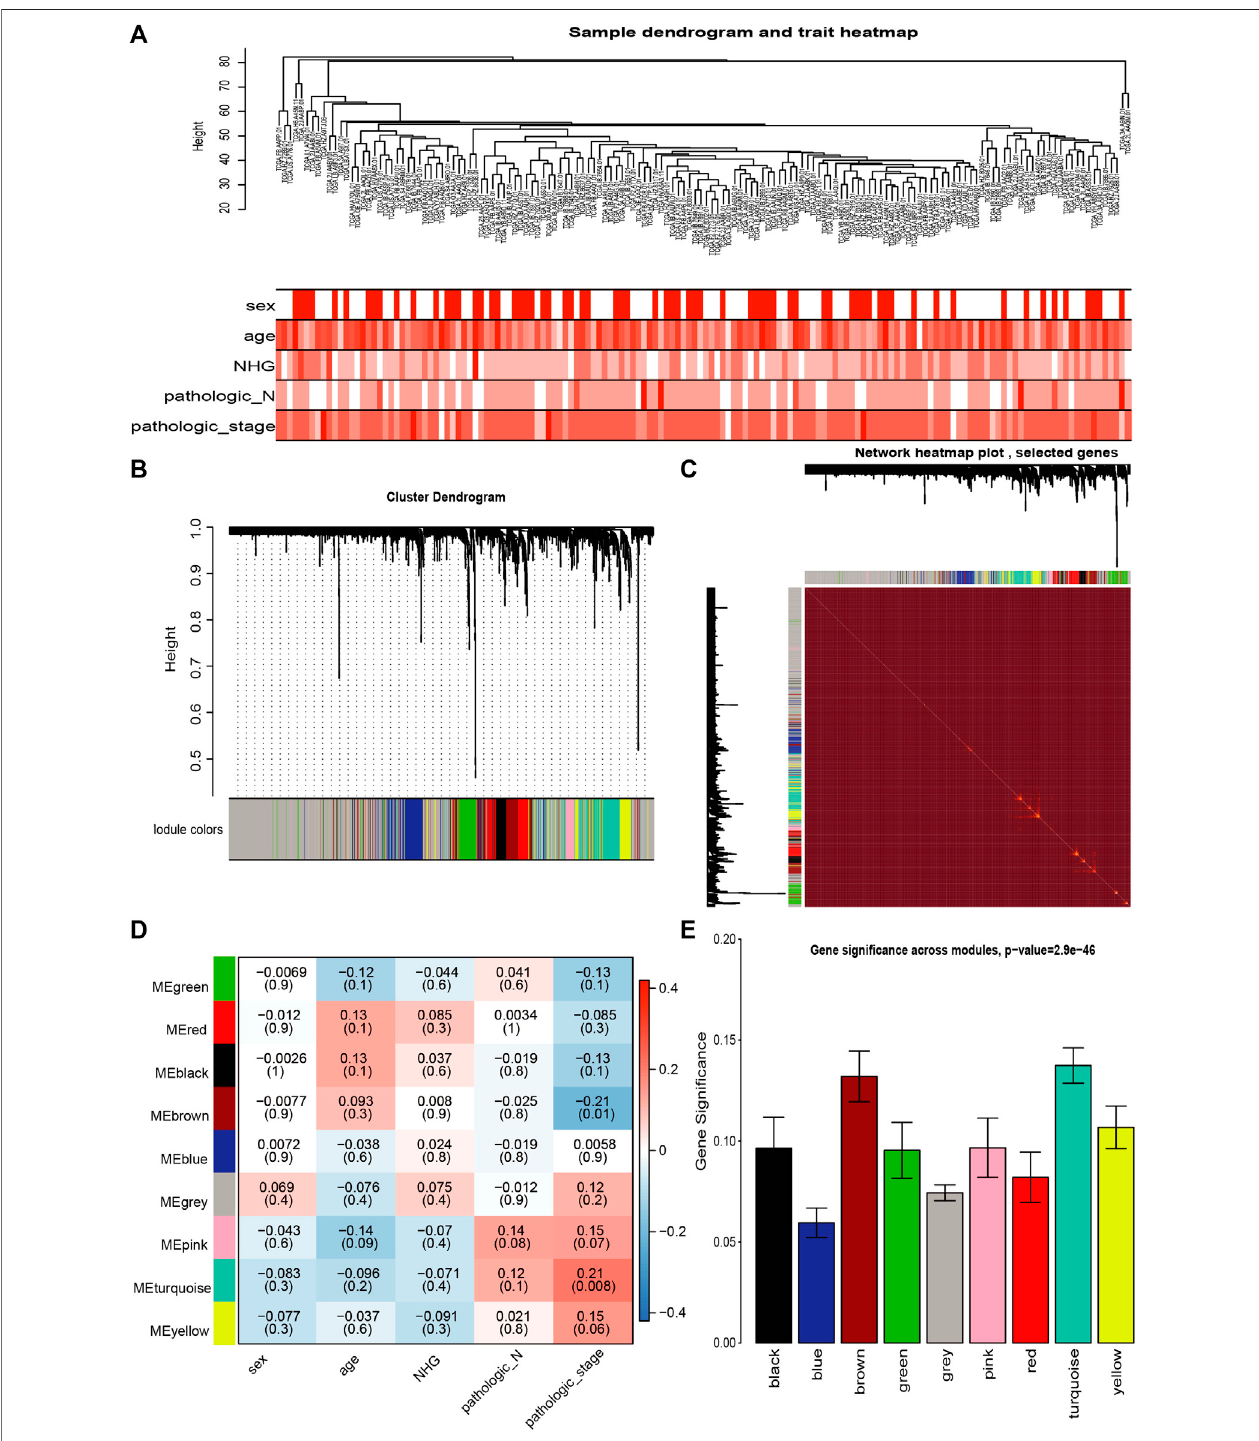
FIGURE 3 | Co-expression analysis of metabolic enzymes genes from the TCGA data (A) Clustering tree of PC samples in the TCGA data. (B) Gene distribution in the WGCNA network analysis. (C) Heatmap plot of the topological overlap in the MEs network. (D) Analysis of relationships between genes in modules between tumor and normal samples. (E) Distribution of pathologic_stage-related genes in all modules. Genes are presented on the X-axis, and the enrichment signi fi cance is shown on the Y-axis.